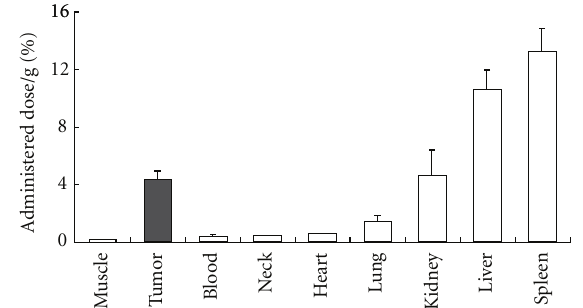
Figure 1: Biodistribution of 125 I-POS in FM3A-bearing mice. Administration dose of 125 I-POS 2.0MBq, POS: 30 μ g, tumor weight: 0.3–2.3 g, tumor uptake 4.3% AD/g, T/B: 13.1%( n =